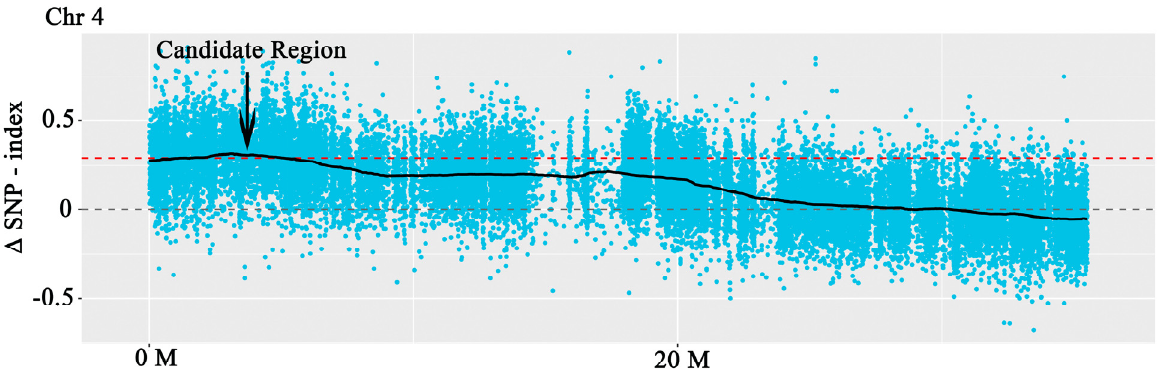
Figure 4. The results of the BSA. Each point in the figure represents the calculated SNP − index or ∆ SNP − index value. The black line represents the SNP − index or ∆ SNP − index value after fitting and the red dashed line indicates the 99th percentile threshold.